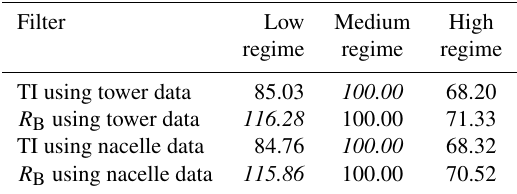
Table 6. AEP in percentage calculated for different filter regimes using a Weibull distribution with a scale factor and a shape fac- tor representative of the corresponding wind speed distribution. Medium regime is set at 100% and low and high regimes are per- centages compared to the medium regime. The highest value within each row is